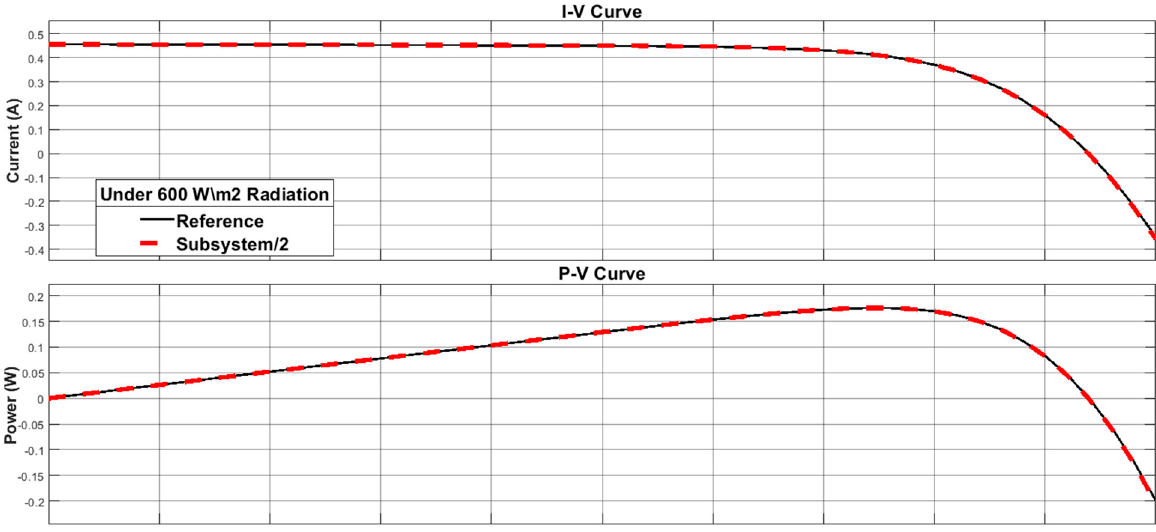
Figure 12. I − V and P − V curves for the reference and the proposed model under 600 W/m 2 radia- tion.